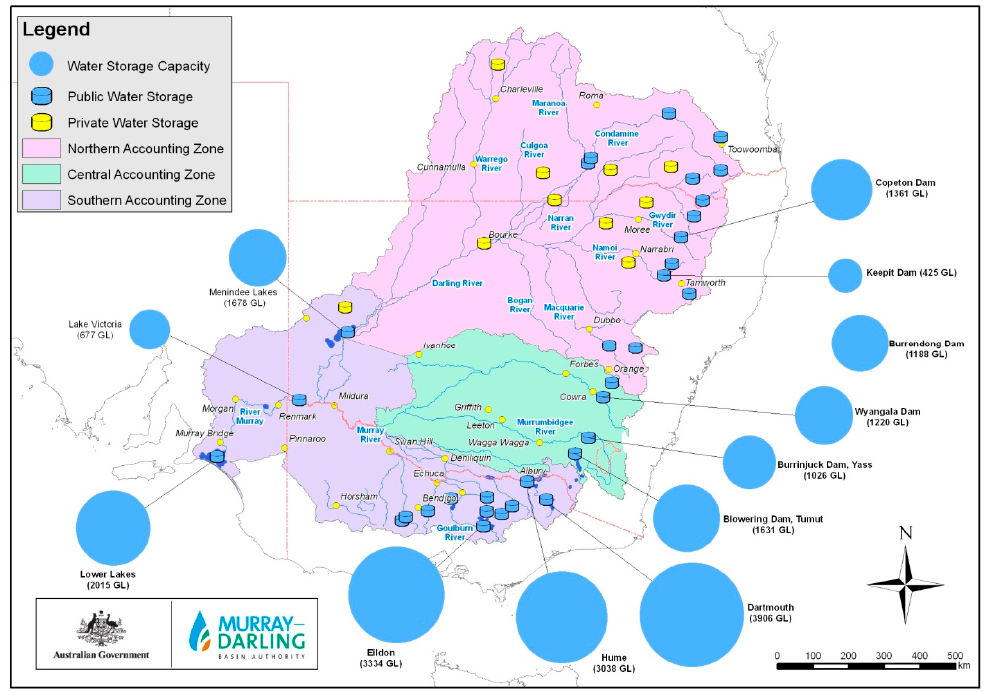
Figure 1. Map of major water storages in the Murray Darling Basin (MDB) indicating major dams on the majority of rivers [32].